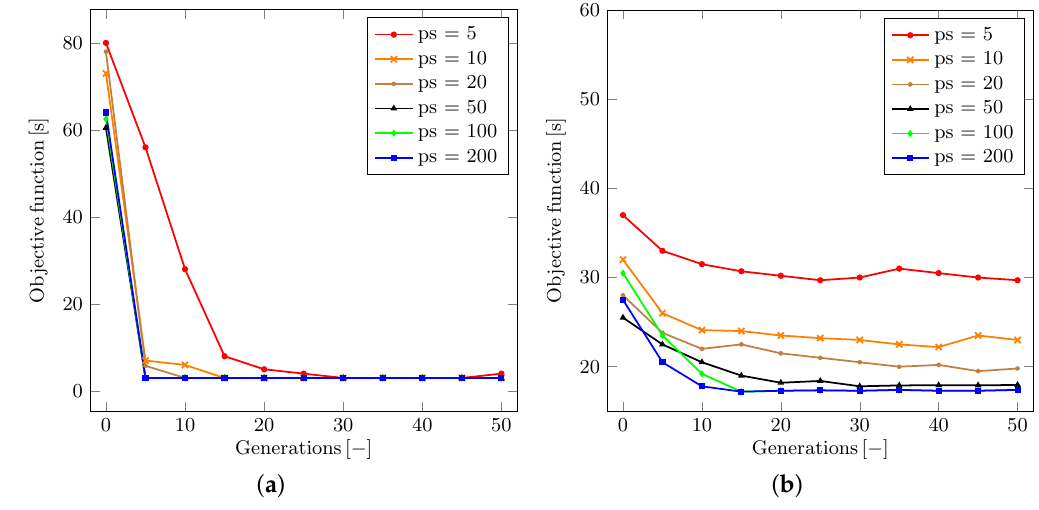
Figure 8. Optimization results with respect to the population size. ( a ) Classical T-shaped junction scenario; ( b ) Real-life